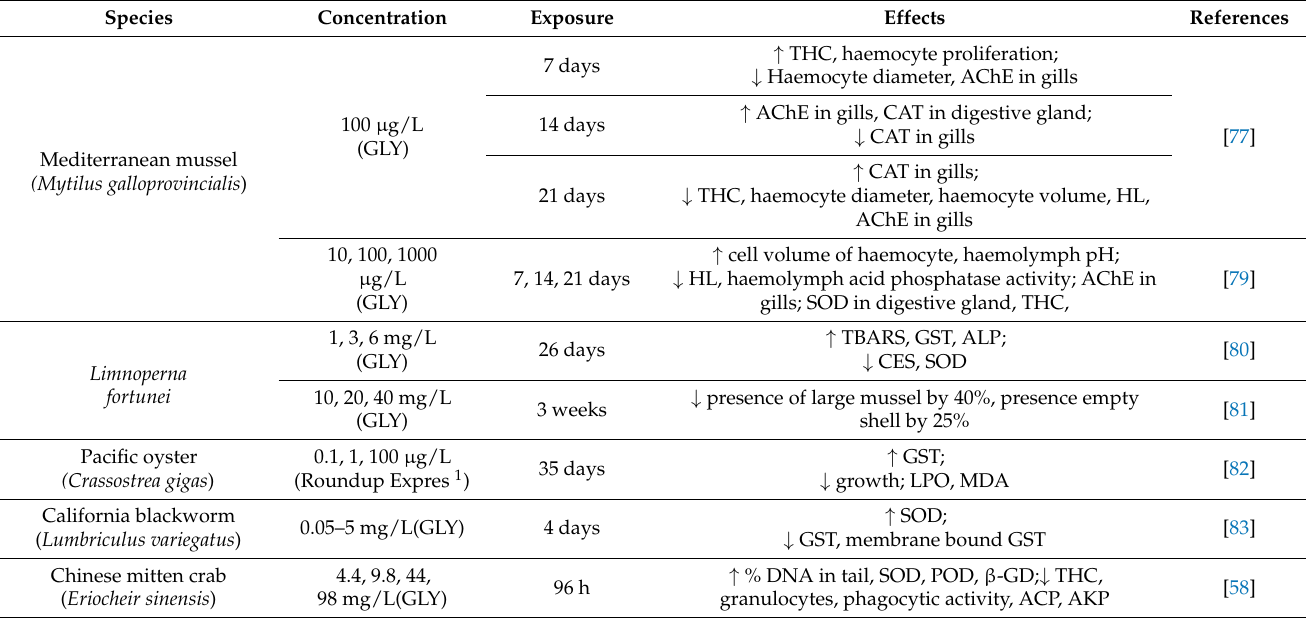
Table 5. Toxic effects of glyphosate and its commercial products on invertebrate